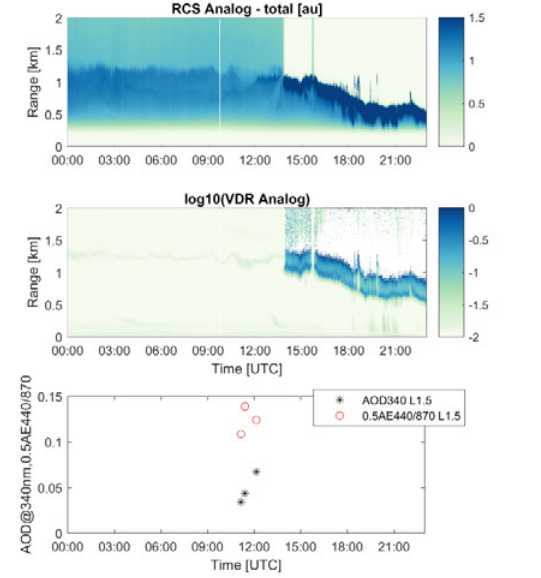
Figure 8. RCS (upper), VDR (middle) and AOD and AE (lower) at Glasgow Bishopton on 05/01/2017after a pollution event. Zoom over [0, 2]